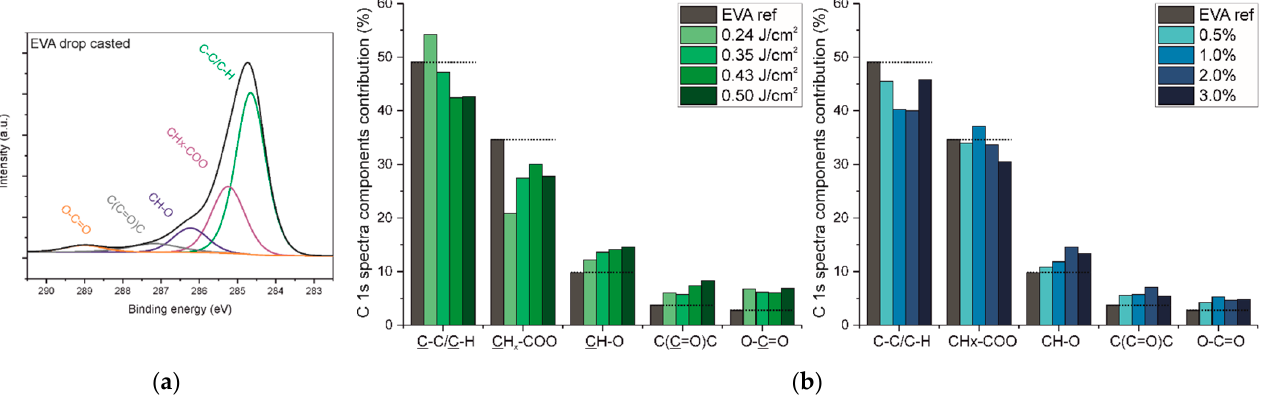
Figure 6. ( a ) High-resolution XPS C 1s spectra obtained for reference EVA coating. ( b ) Carbon components’ contributions from high-resolution XPS C 1s spectra deconvolution of two series of EVA coatings: left—green with variable laser fluences; right—blue with variable concentrations of the EVA solution. The individual bond contribution values of reference EVA coating were used for guidance in the analysis of MAPLE deposited coatings, shown as dotted line. Table 3. Assignment of the C 1s components applied to the fitting procedure of high-resolution XPS C 1s